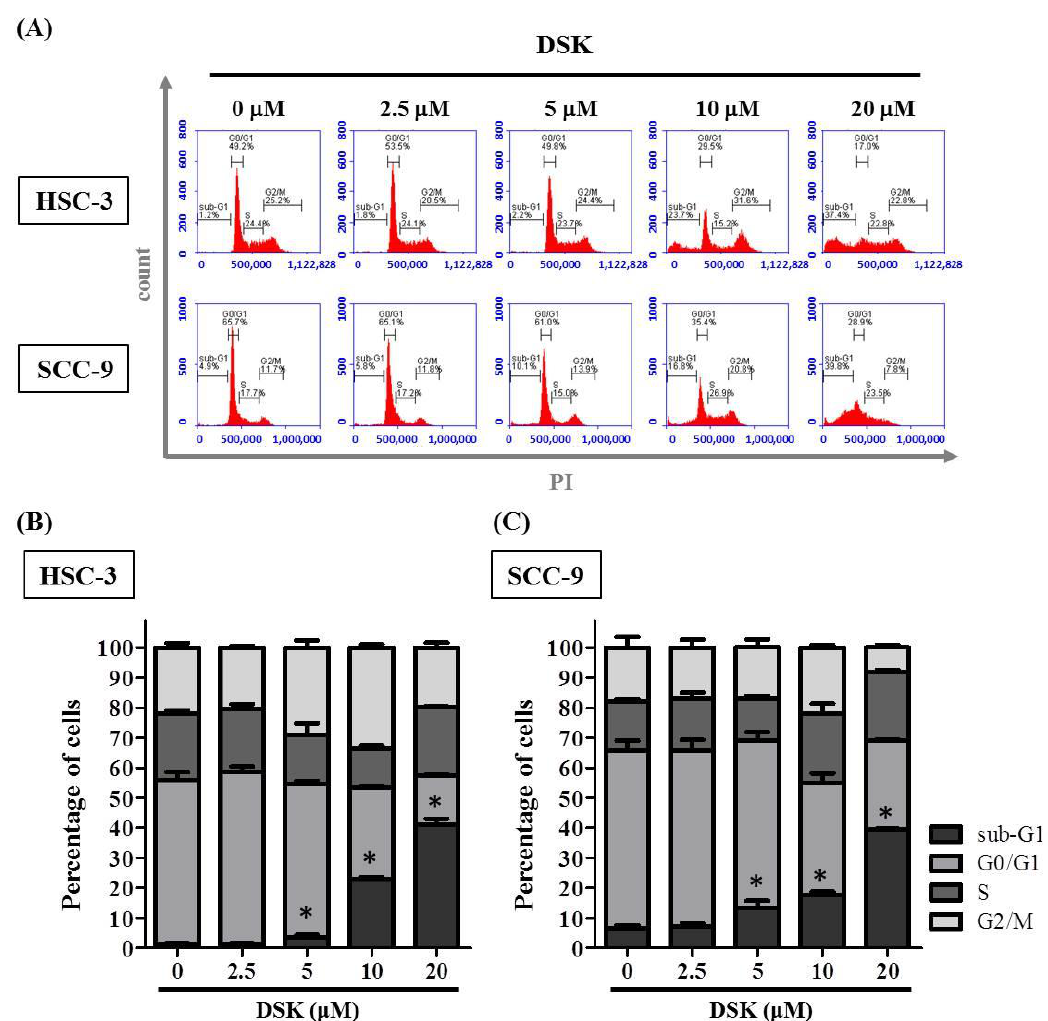
Figure 2. DSK induces sub-G1-phase cell cycle arrest of o tongue cancer cells. ( A ) DNA contents of tongue cancer cells (HSC-3 and SCC-9) treated with indicated concentrations of DSK for 24 h were monitored by PI staining using flow cytometry. ( B , C ) Quantification of cell cycle distribution in ( B ) HSC-3 and ( C ) SCC-9 cell lines. The values represent the mean ± SD of three independent experiments. * p < 0.05 compared with untreated controls using Student’s t